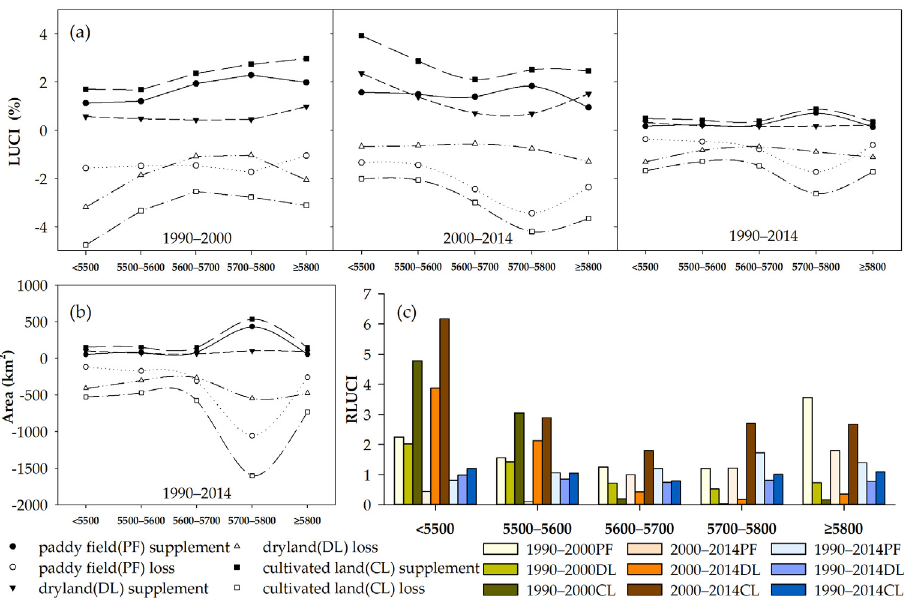
Figure 6. Changes in cultivated land under di ff erent temperature conditions. ( a ) The variation in land-use change intensity at di ff erent temperature zones in di ff erent periods, ( b )the change of area in cultivated land at di ff erent temperature zones during 1990–2014, ( c ) the ratio of cultivated land change at di ff erent temperature zones compared to that in the whole Hunan province.